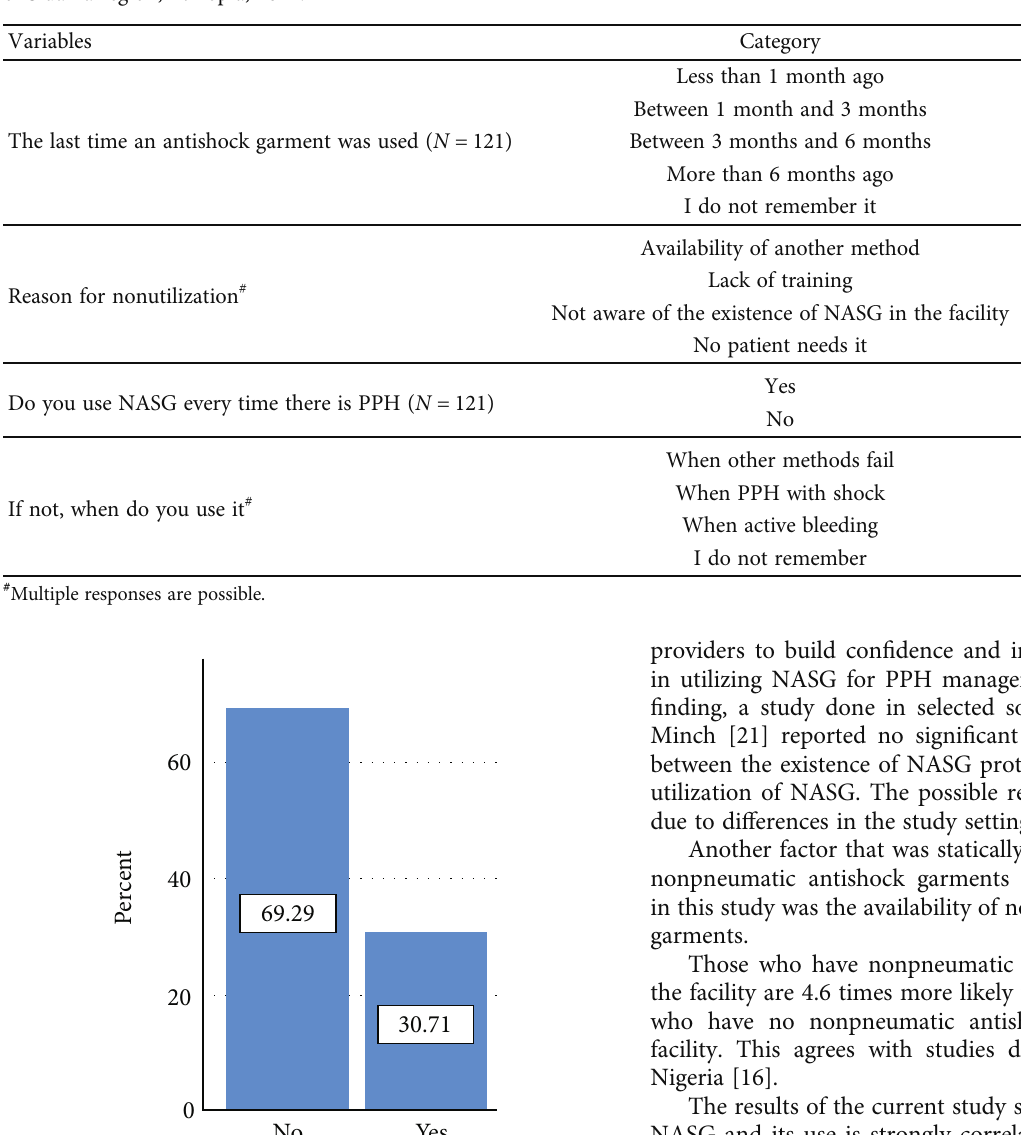
Table 5: Utilization of nonpneumatic antishock garment by respondents who participated in the study and were working in public hospitals of Sidama region, Ethiopia, 2022.